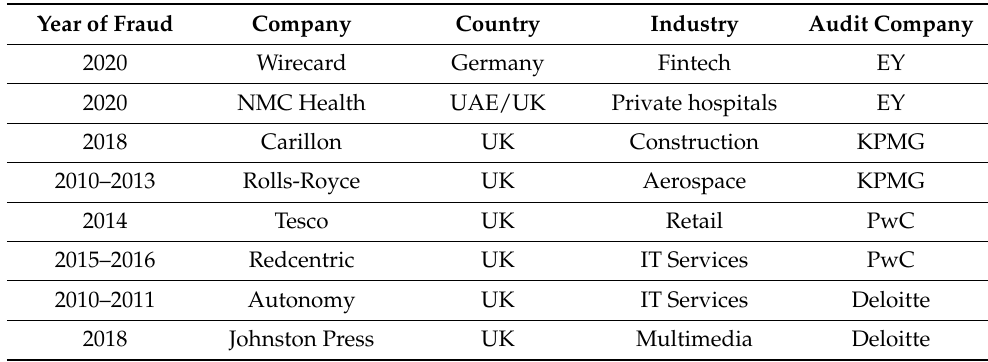
Table 2. Two identified recent failures for each of the Big Four audit